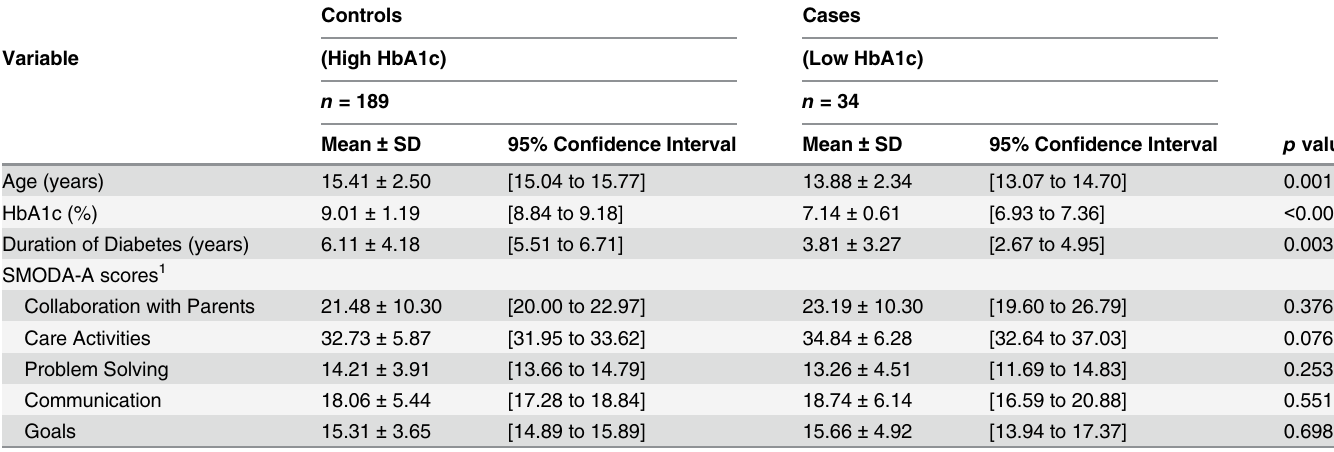
Table 1. Comparison of characteristics of patients with type 1 diabetes recruited between January 2012 and April 2013, from the Pediatrics Endo- crinology Clinic at the University of Massachusetts Medical School (Continuous